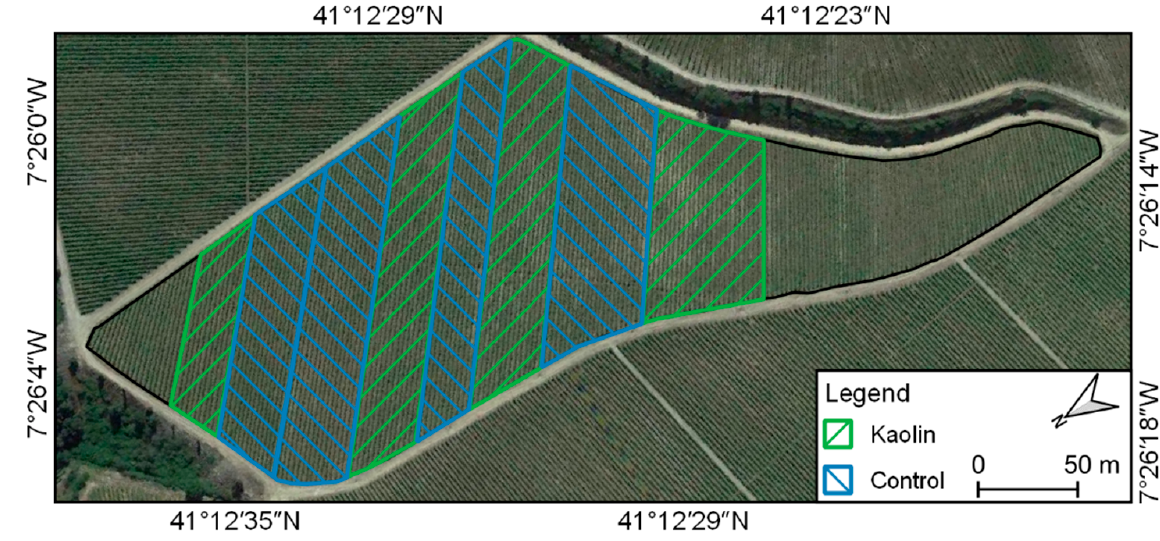
Figure 1. Overview of the surveyed vineyard and the parts analysed. Background image from Google Earth.